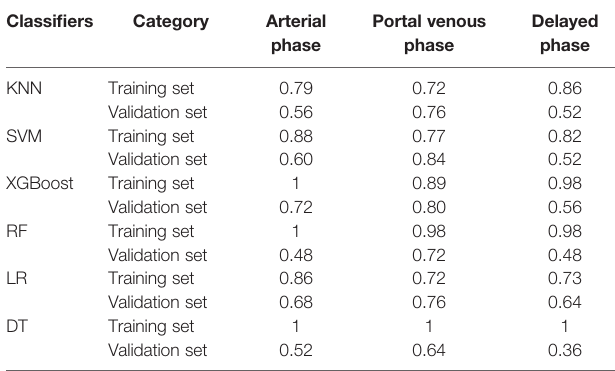
TABLE 3 | Results of score matrix of training sets and validation sets in arterial phase, portal venous phase, and delay phase.